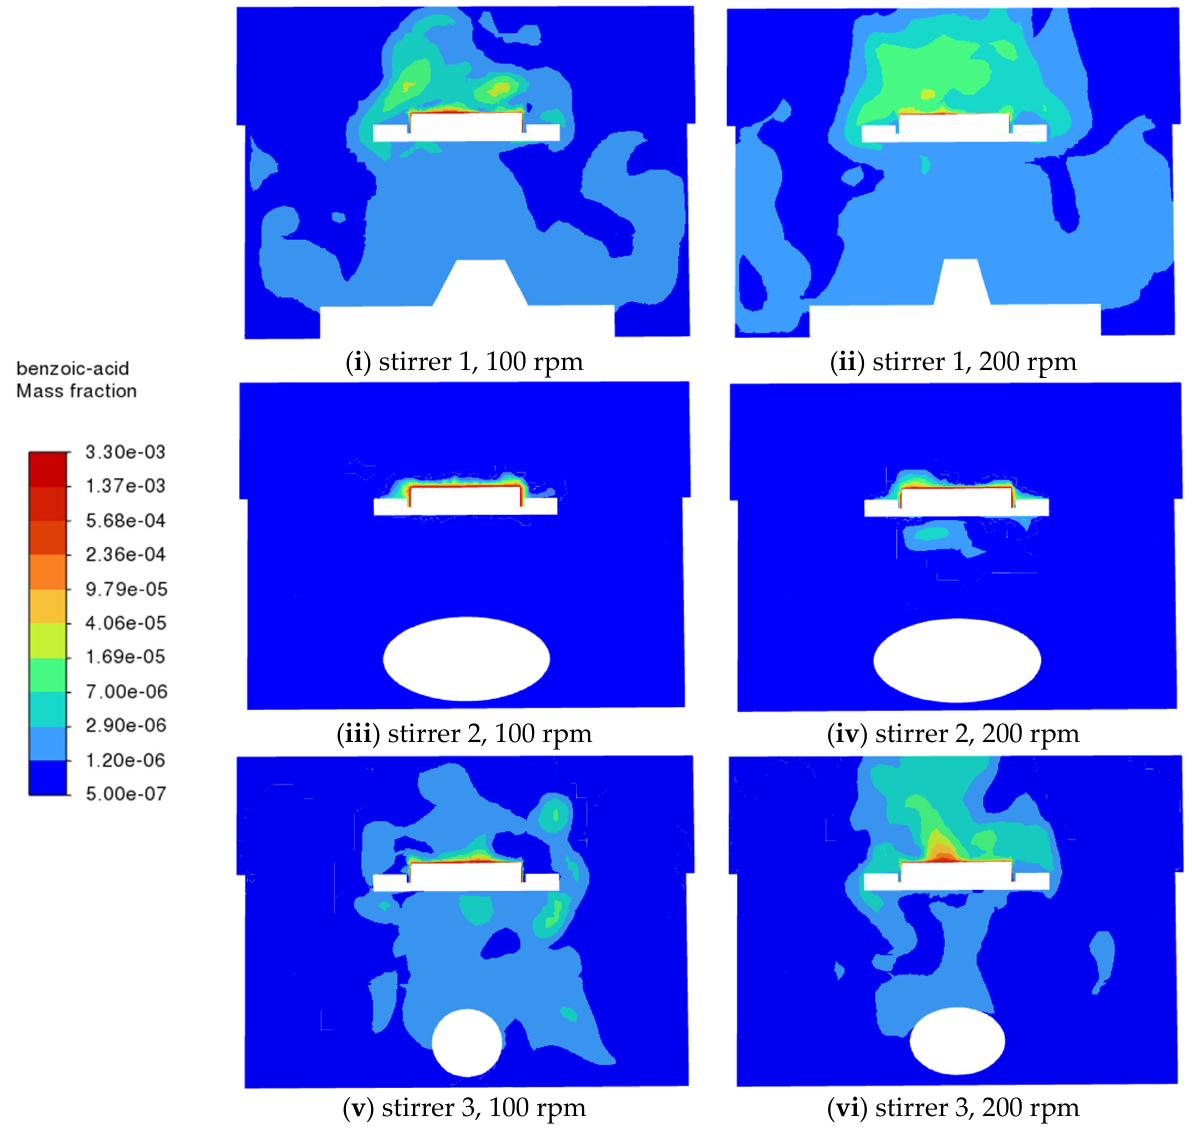
Figure 4. CFD predictions of the benzoic acid mass fraction on the vertical middle cross-section for different stirrers at different rotation speeds (100 rpm and 200 rpm).